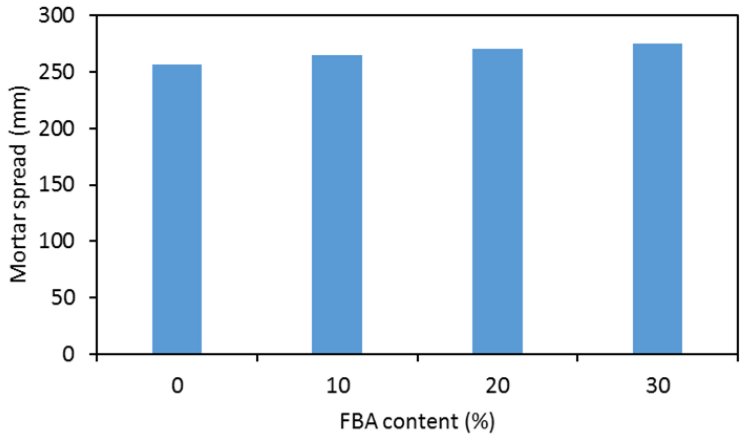
Figure 3. Average spread flow vs FBA content.